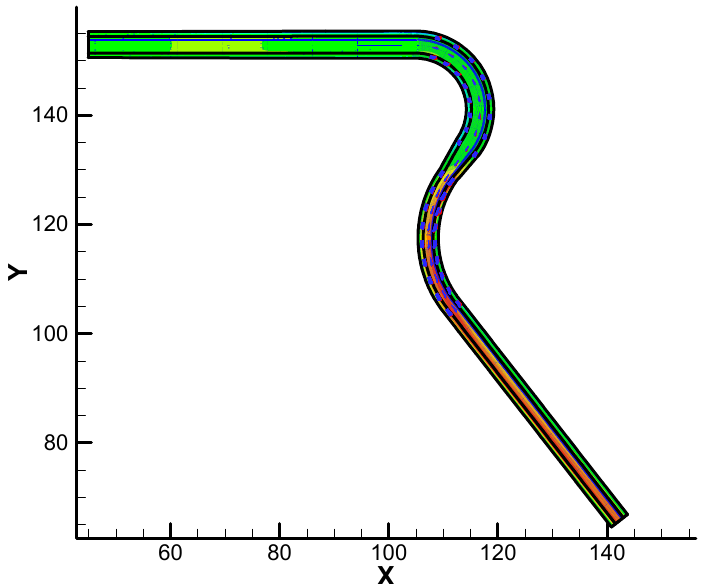
Figure A5. Plan-view (in meters) of simulated surface velocities from the U 2 RANS model and measured velocity vectors.